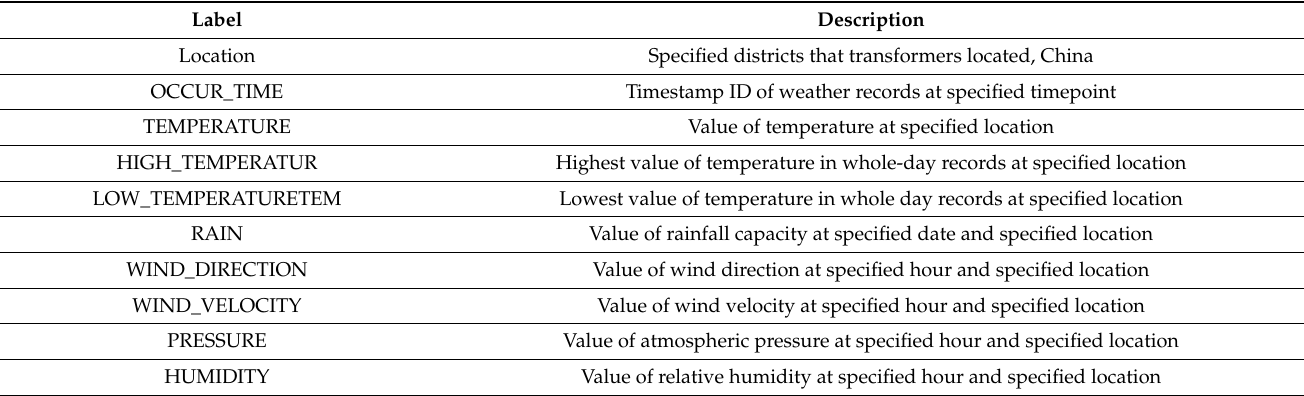
Table 2. Description of weather data.